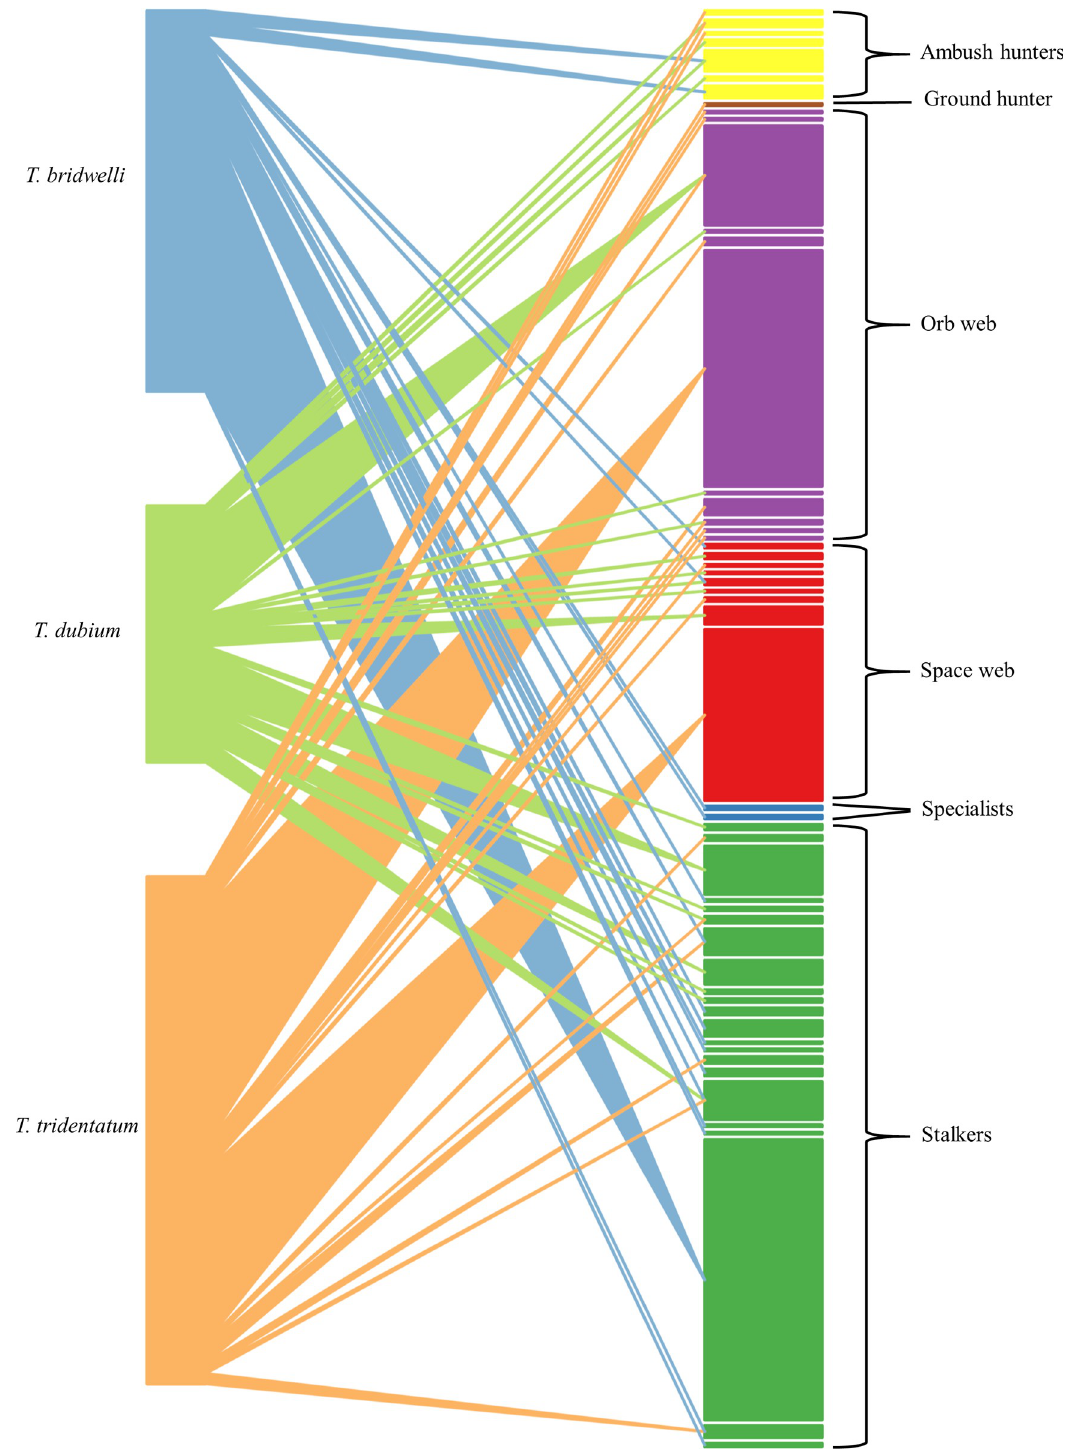
Fig 5. Bipartite interaction between wasps and spider guilds. Each guild contains the total number of spider species (right bars) preyed upon by each wasp species (left bars). The thickness of bars indicate the abundance of predators and prey, respectively. The line thickness represents the abundance of individuals captured by each wasp